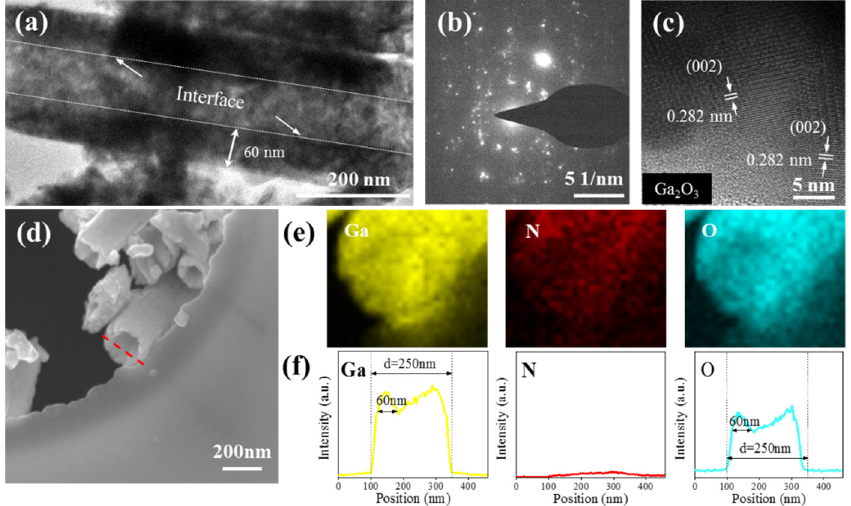
Figure 5. ( a ) TEM image of a single β -Ga 2 O 3 nanotube (NT) oxidized at 950 °C for 10 min. ( b ) SAED pattern and ( c ) HRTEM image of the β -Ga 2 O 3 NT. ( d ) The SEM graph of individual Ga 2 O 3 NT, ( e ) corresponding EDS elemental mapping images, and ( f ) EDS line scanning.